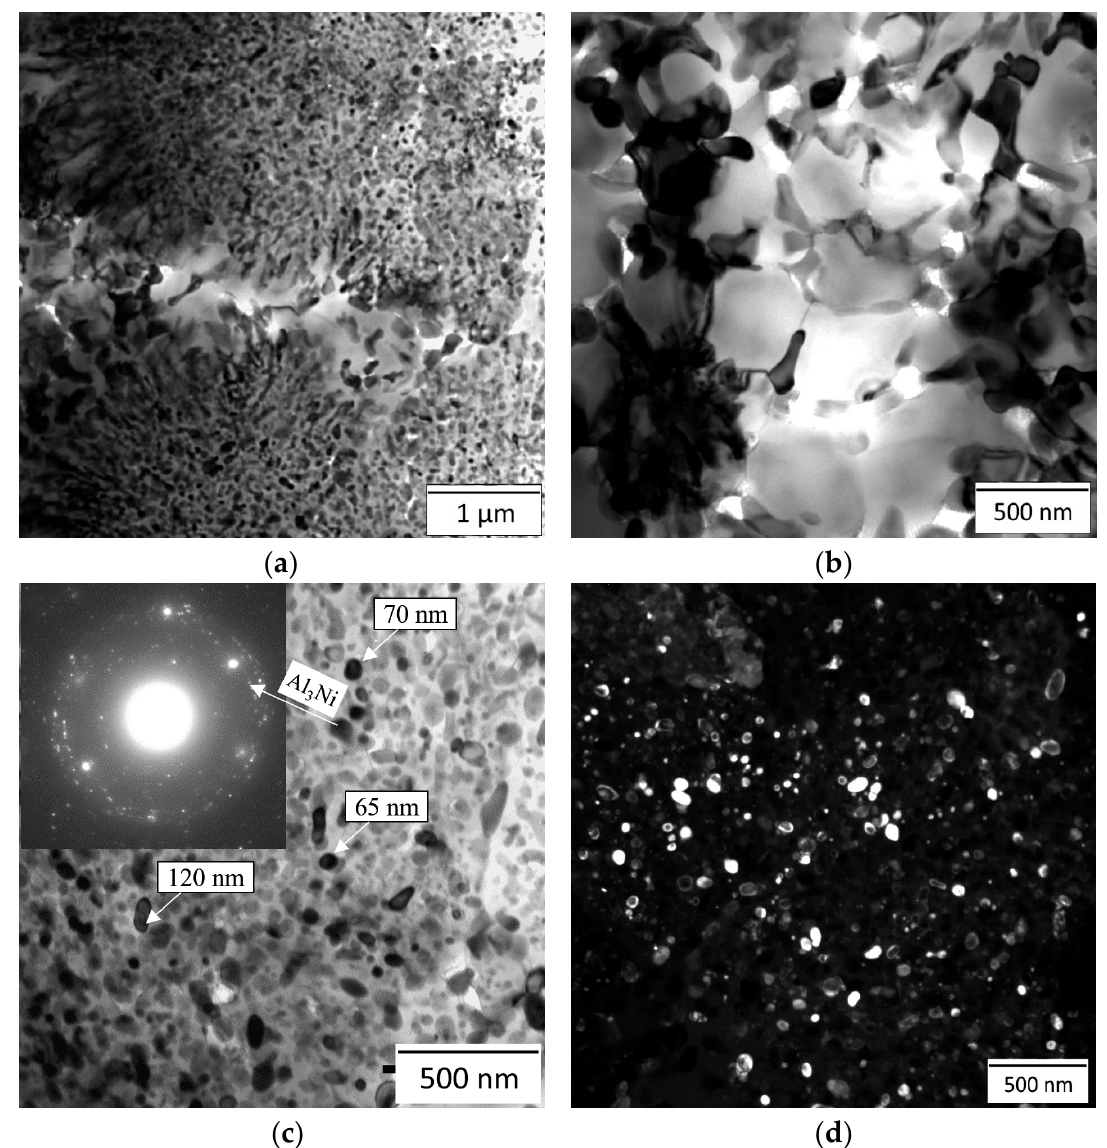
Figure 7. Microstructure of the melt-spun ribbons (MS sample, 2.3 × 105 K/s) of the Al8Zn7Ni3Mg alloy: ( a ) general view of the intermetallic bands; ( b ) a (Al) dendritic structure appeared in the bands’ vicinities; ( c ) light field image of the globular intermetallcs’ band; ( d ) dark field image.